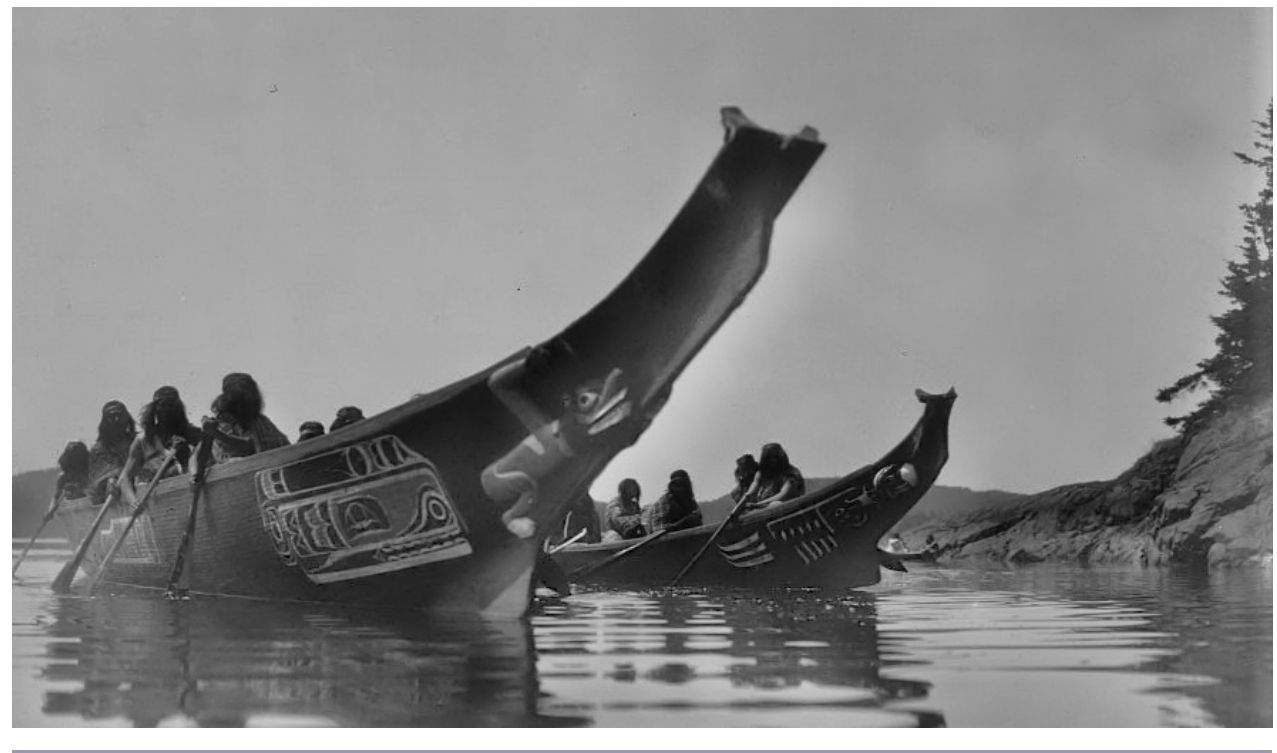
Fig. 2. Indian Dugout Canoes. Source: Library of Congress, Prints & Photographs Division, Edward S. Curtis Collection [reproduction number